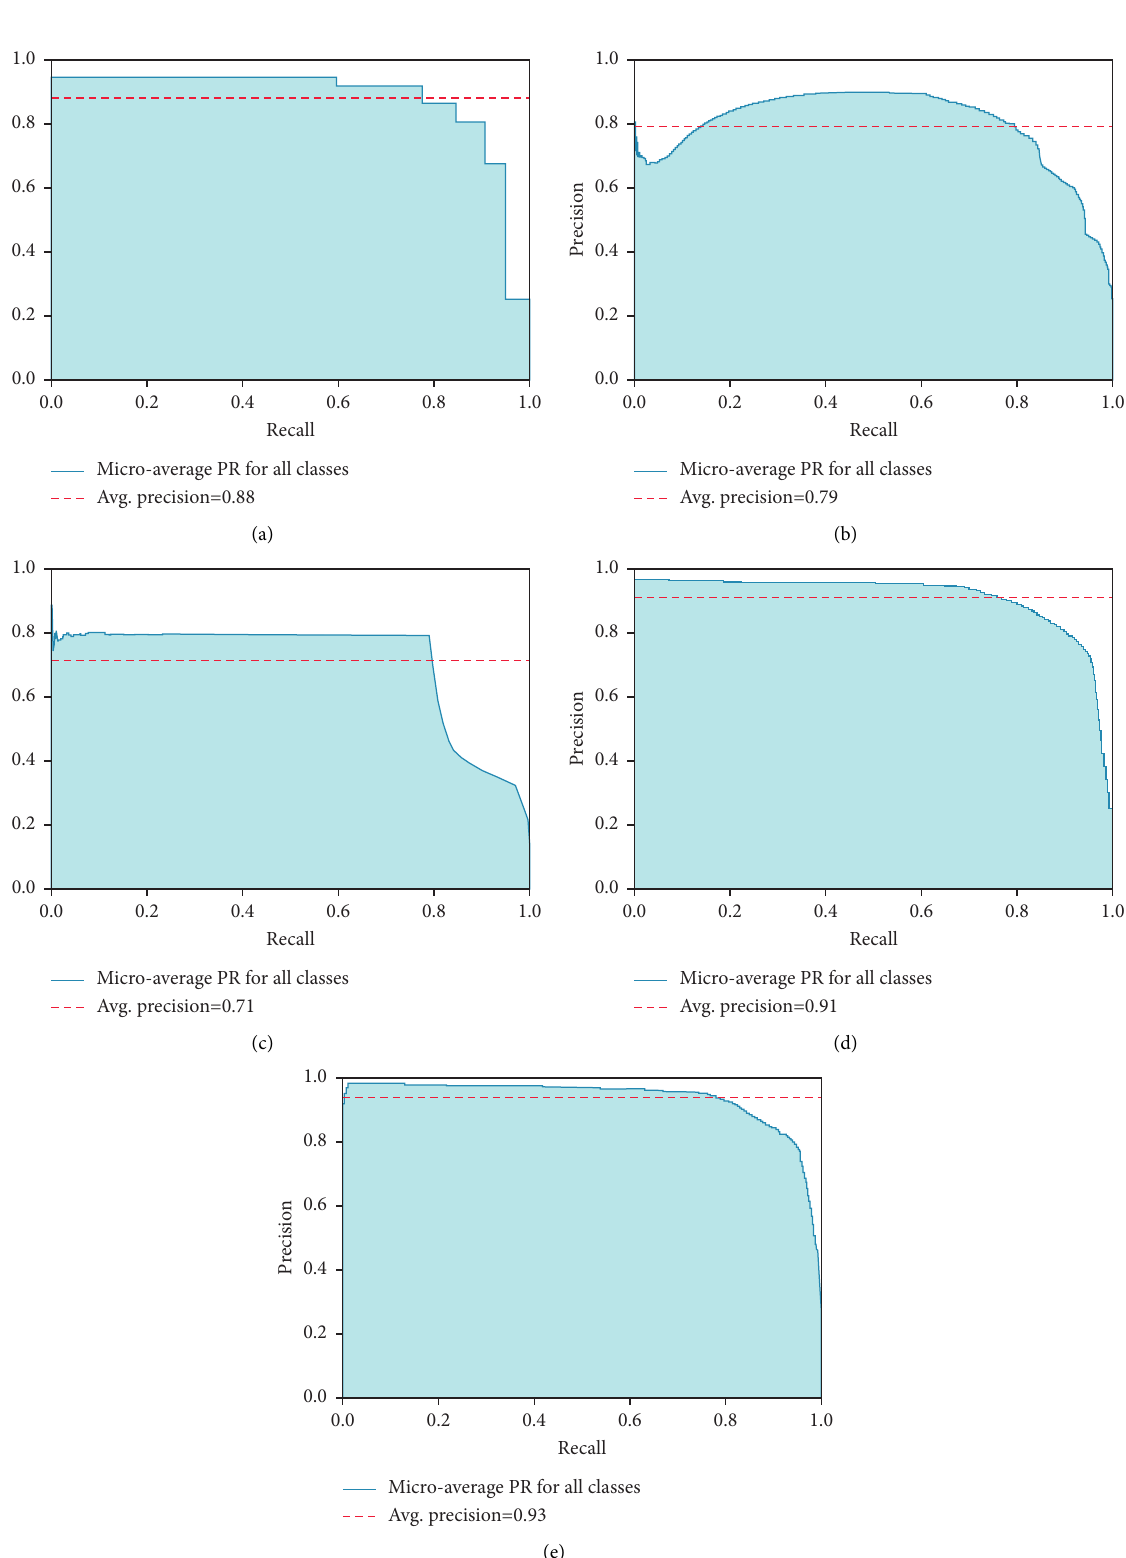
Figure 6: Precision-recall curve for different models. (a) KNN. (b) NB. (c) SVM. (d) RF. (e)